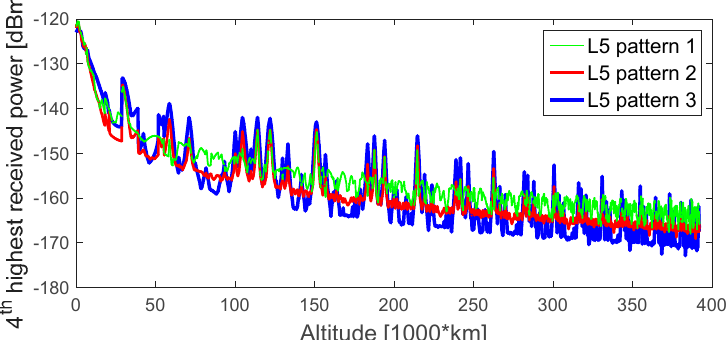
Figure 22. Fourth-highest received power level of GPS L5 signals, during the considered MTO, for a 0 dBi receiver gain pattern.